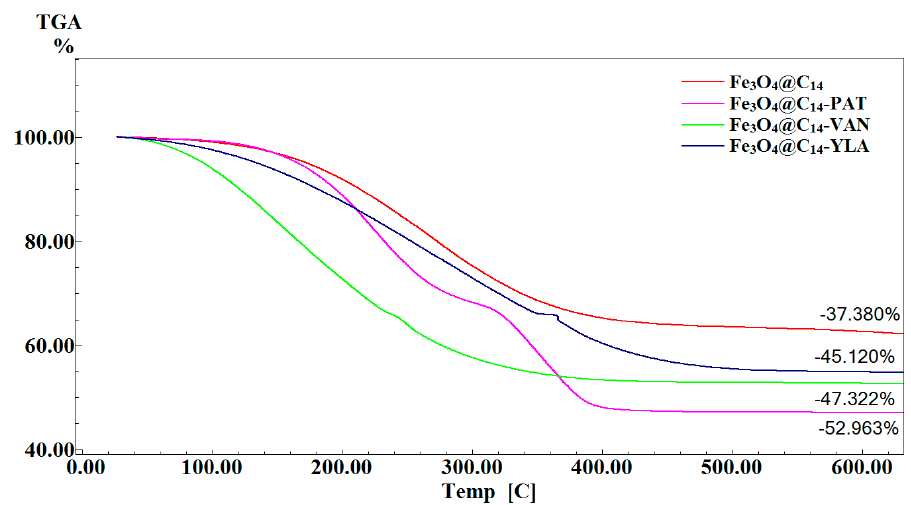
Figure 3. TG [C] analysis of Fe 3 O 4 @C 14 and Fe 3 O 4 @C 14